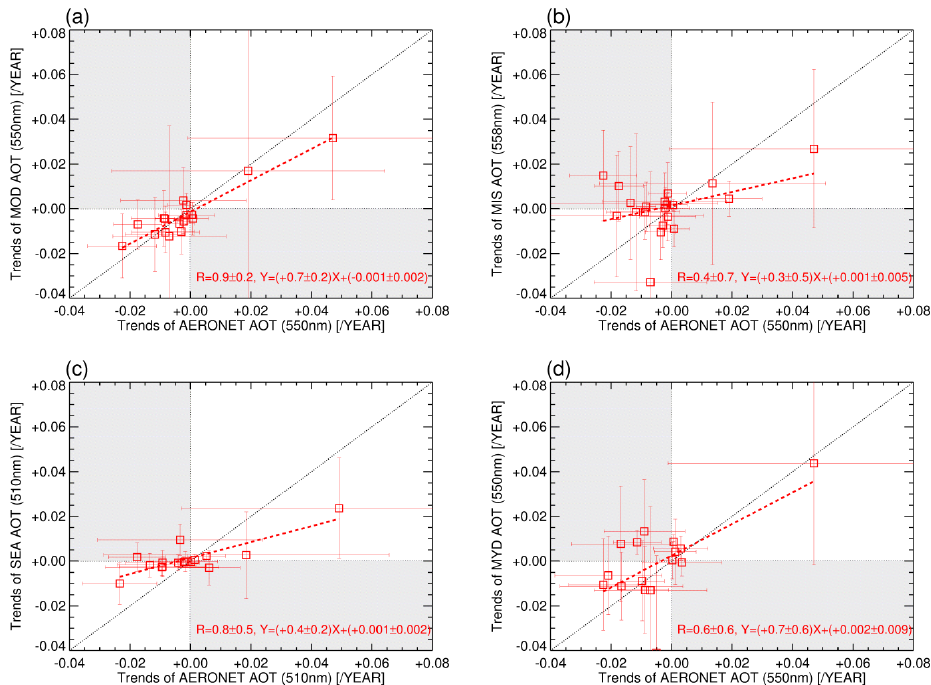
Figure 8. Scatter plots of comparison between the weighted trends of AERONET and (a) MODIS (Terra), (b) MISR (Terra), (c) SeaWiFS (OrbView-2), and (d) MODIS (Aqua)